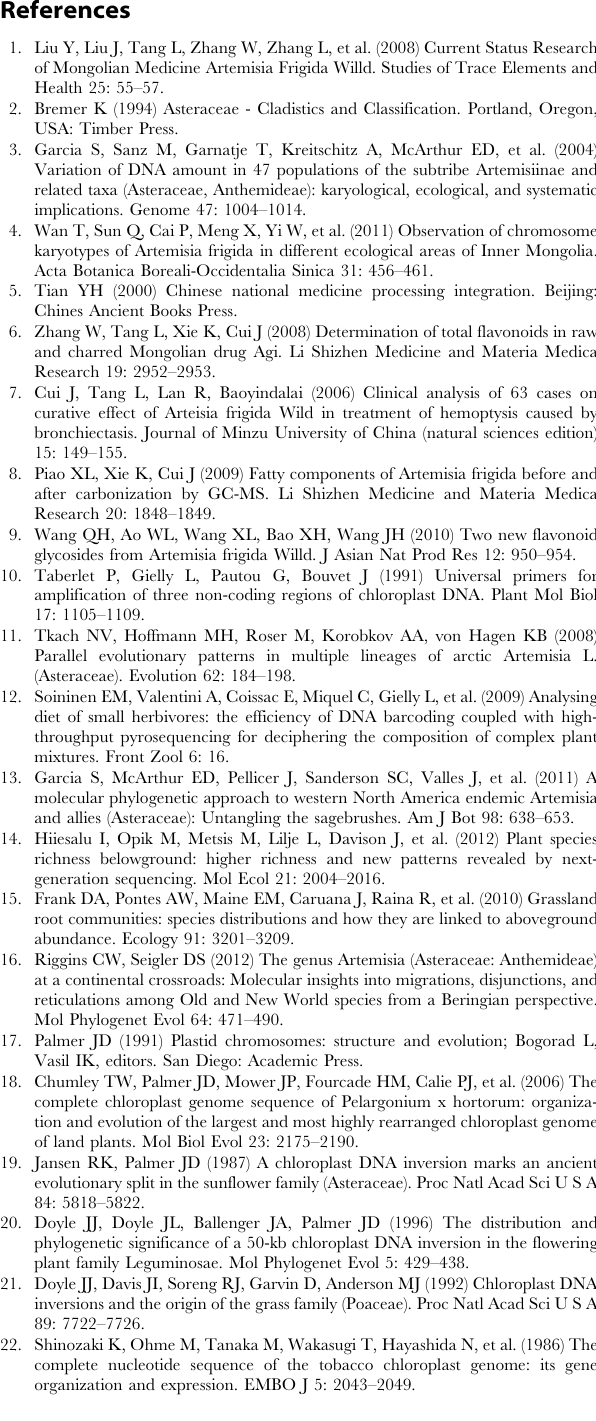
Table S3 Size comparison of Artemisia frigida chloroplast genomic regions with those in other species of Asteraceae. Table S4 The GenBank accession numbers of all the 58 cp genomes used for phylogenetic analysis. Table S5 The GenBank accession numbers of ndhF gene and trnL-F gene region from all the 92 species used for phylogenetic